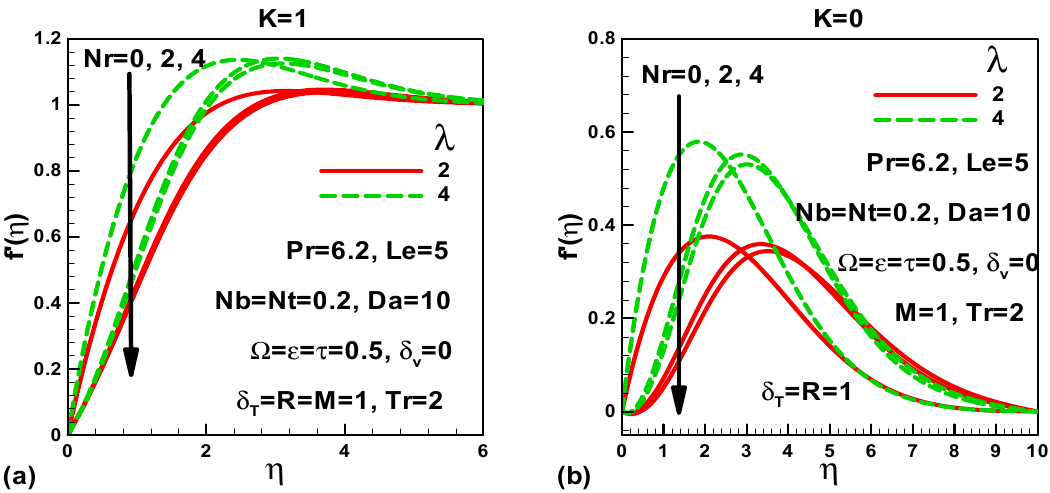
Figure 2. Effects of buoyancy ratio and mixed convection parameters on dimensionless velocity ( a ) with pressure gradient and ( b ) without pressure gradient.